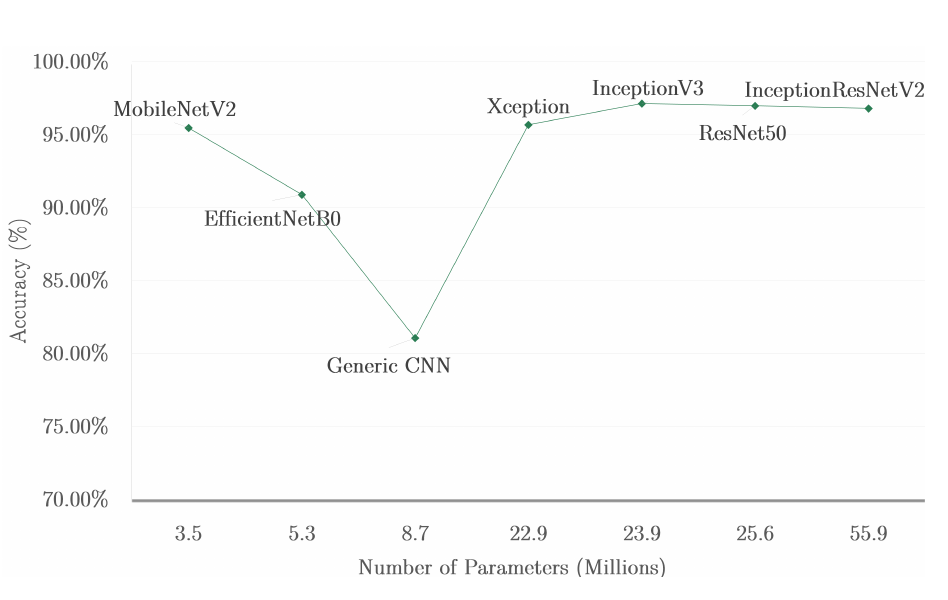
Figure 13. Model Size versus Model Accuracy . All numbers are indicated in millions for every single